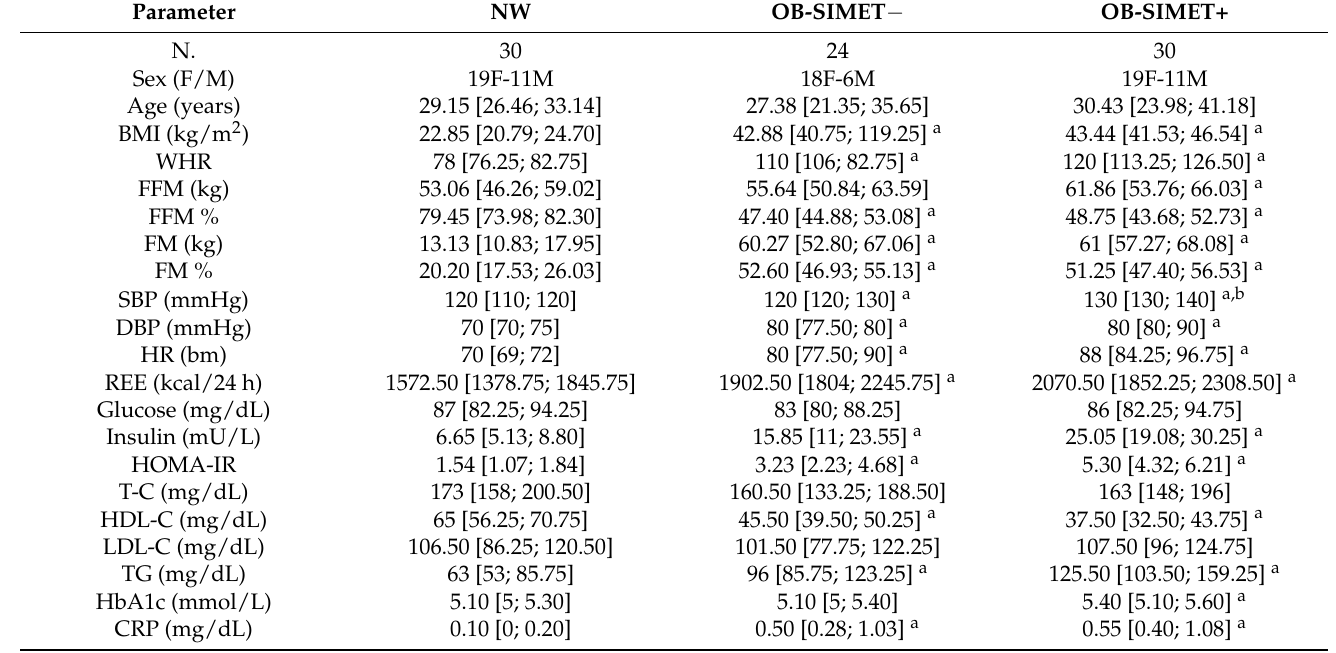
Table 1. Demographic, clinical and biochemical characteristics of the study population, subdivided into three groups: normal-weight (NW) and obese subjects without (OB-SIMET − ) or with (OB- SIMET+) metabolic